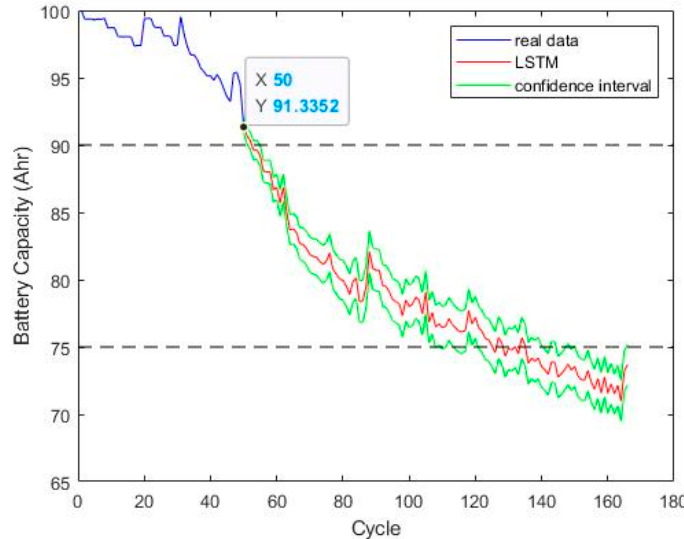
Figure 15. Prediction results of RNN (after 50 cycles).